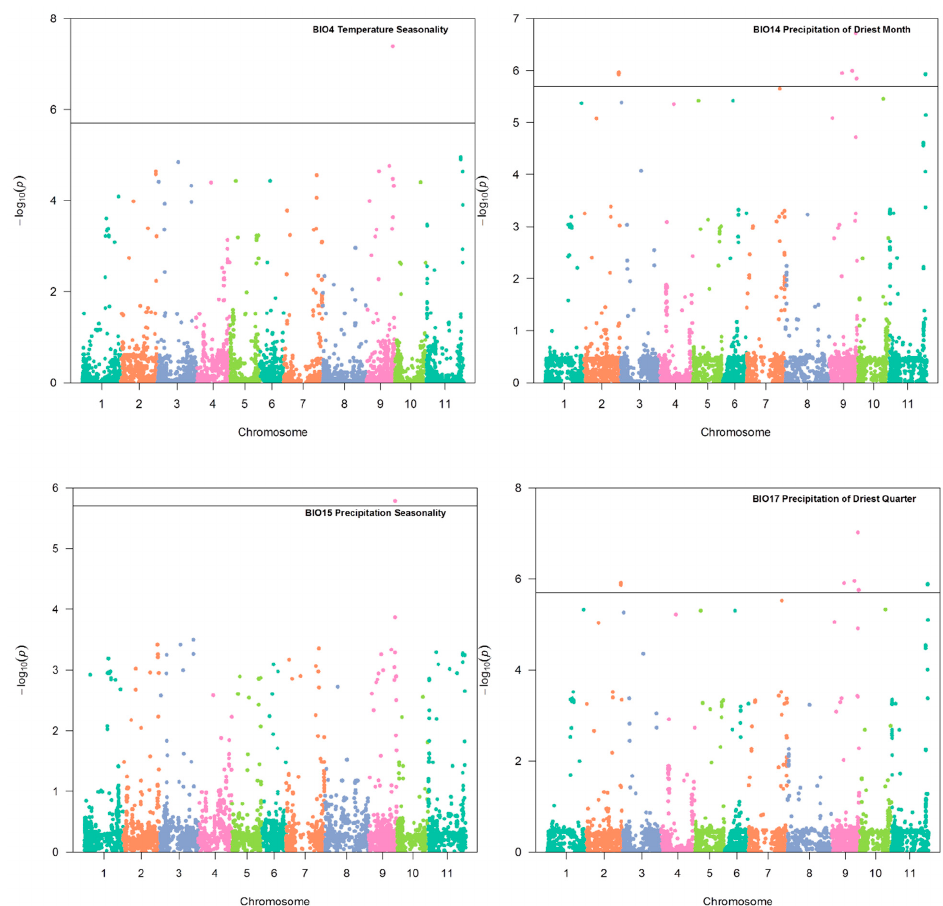
Figure 4. Genome–environment association analysis in common bean accessions. Manhattan plot showing candidate single nucleotide polymorphisms and − log10 ( p -values) for bio-climatic variables BIO4, BIO14, BIO15, and BIO17. The horizontal black line corresponds to the Bonferroni significance threshold (1.73 × 10 − 6 for α = 0.05 and 28,823 SNP markers).